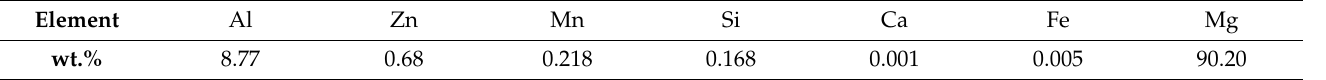
Table 1. Chemical composition of magnesium alloy